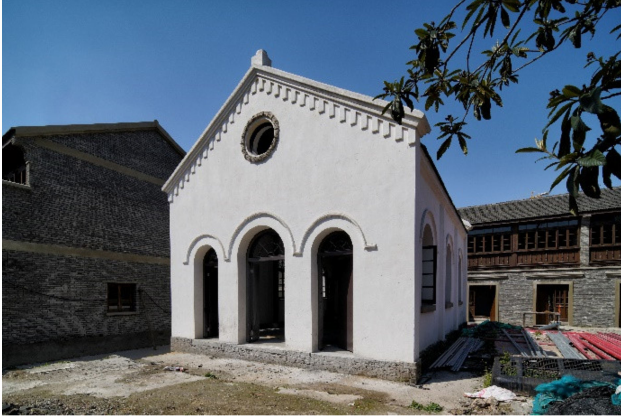
Figure 8. Xiaguan Catholic Church (south